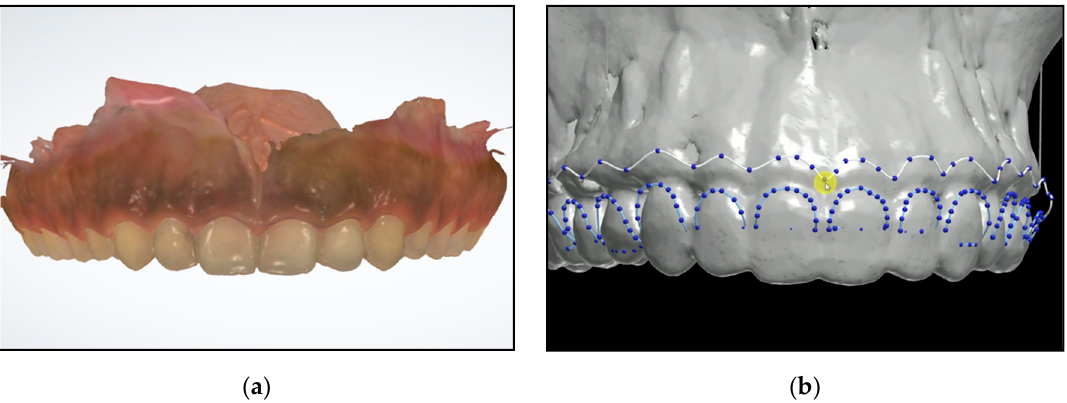
Figure 3. ( a ) Intraoral scan of the maxillary jaw; ( b ) After superimposition of the CBCT and the intraoral scan, the cementoenamel junction and future bone level marked.